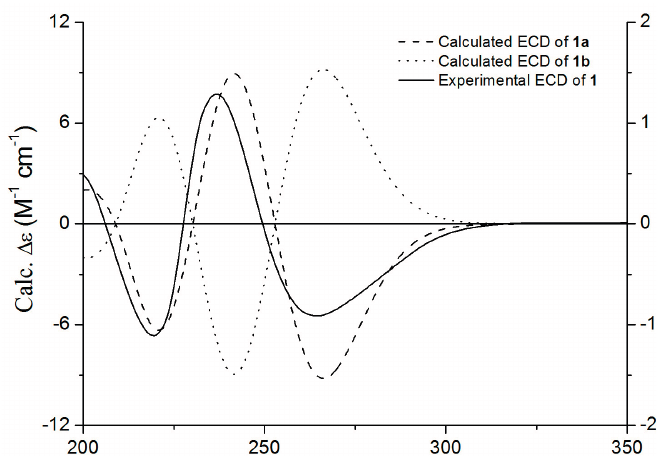
Figure 3. Experimental and calculated ECD spectra of 1